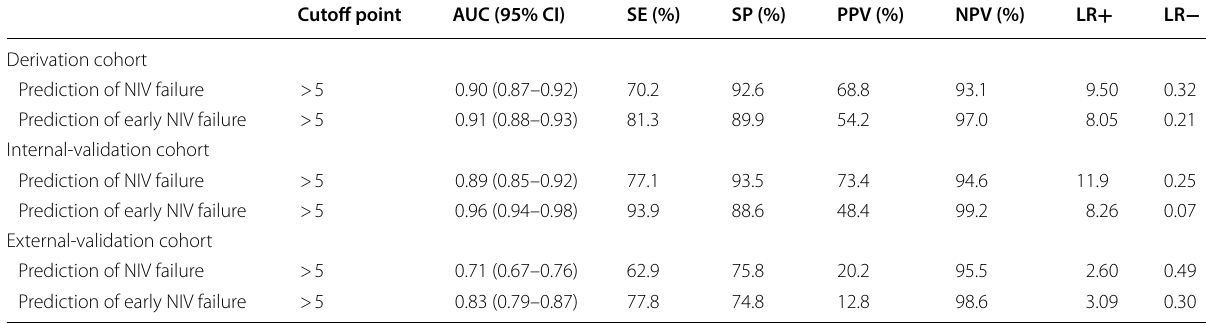
HACOR heart rate, acidosis, consciousness, oxygenation and respiratory rate, NIV noninvasive ventilation, AUC area under the curve of receiver operating characteristics, CI confidence interval, SE sensitivity, SP specificity, PPV positive predictive value, NPV negative predictive value, LR